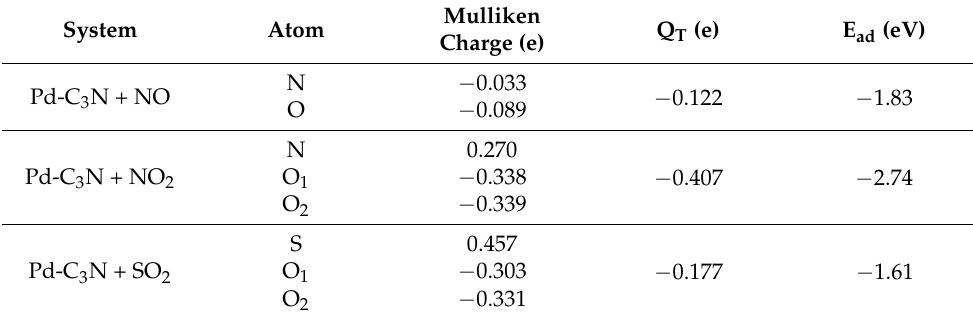
Table 4. The characteristic parameters of three gas adsorption